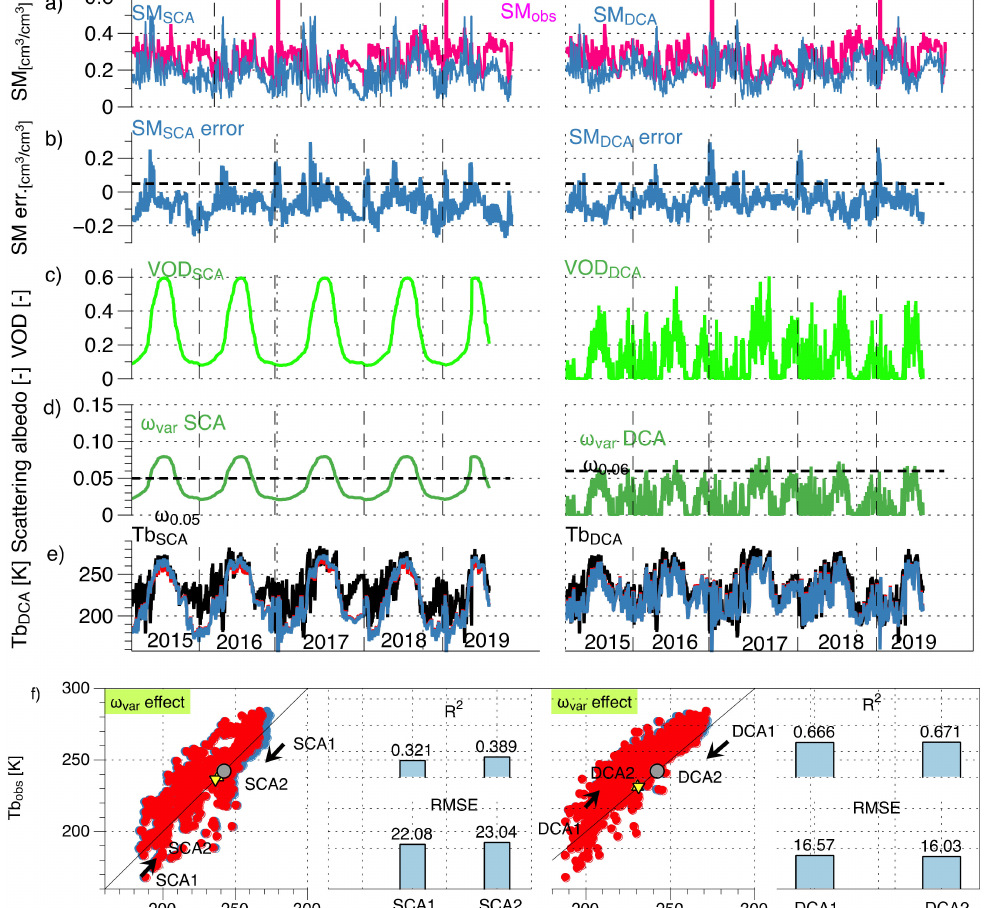
Figure 6. Validation of the improvement by applying time-varying ω within SCA and DCA approaches; ( a ) the soil moisture estimation by SCA (left) and DCA (right), ( b ) their uncertainty, ( c ) SCA and DCA VOD, ( d ) the constant adapted by the SMAP algorithm and the proposed time-varying ω . ( e ) The brightness temperature simulated by τ - ω model applied with the constant and time-varying ω from ( d ) and the input of the in-situ soil moisture presented in (a) in South Fork (crop type: corn) (latitude: 42.42, longitude: − 93.41). ( f ) (cid:78) : mean SCA and DCA1, (cid:72) : mean SCA and DCA2, • : mean SMAP Tb measurements, → : direction of change from mean SCA and DCA1 to SCA and DCA2 towards the reference